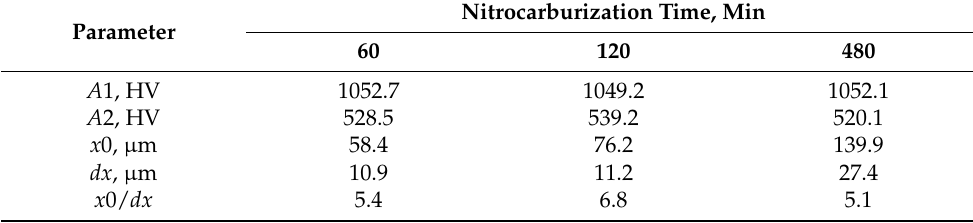
Table 5. The parameters of the sigmoid curve according to Equation (4) for different nitrocarburiz- ing times.